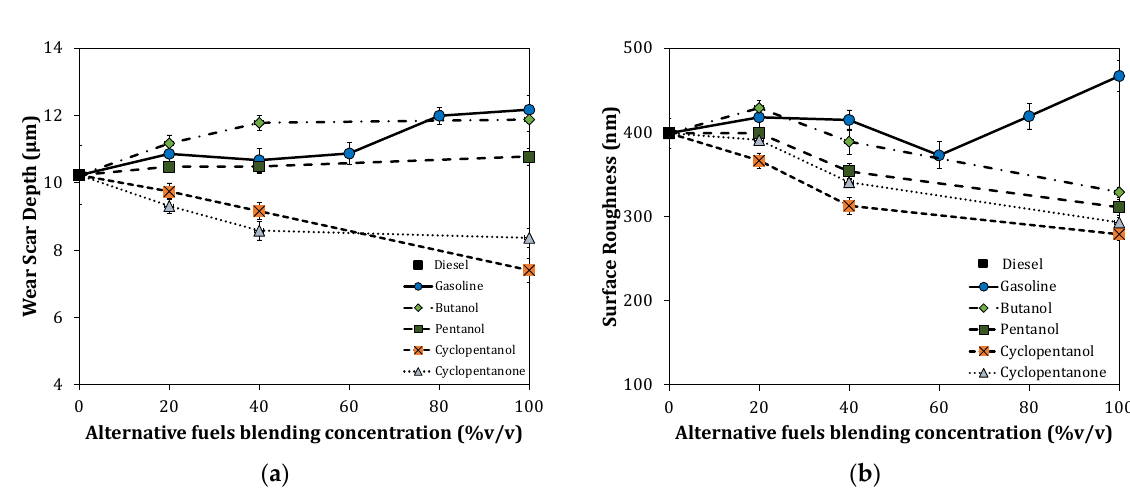
Figure 3. ( a ) Wear scar depth and ( b ) surface roughness of the disc tested in the neat fuels and their blends with diesel (i.e., 0: neat diesel, 100: neat alternative fuel).